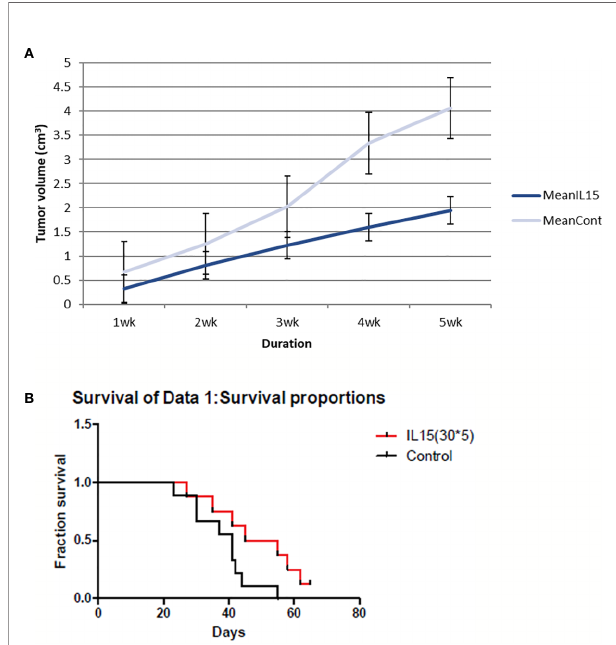
FIGURE 1 | 4T1 tumor volume and mice survival graph after IL-10 injection compared to control mice (n=12 each group). (A) Tumor volume was measured every week after 4T1 cell inoculation with or without IL-10 treatment. Grey line means control group and blue line means the IL-10 group. IL-10 therapy caused statistically signi fi cant tumor volume shrinkage (standard error is used in the graph). (B) Mice survival was measured each week after 4T1 cell inoculation with or without IL-10 treatment. Red line means IL-10 treated group and black line means control group. IL-10 treatment signi fi cantly prolonged mice survival. (Likelihood P value=0.020, median survival for control group=35.5 days and for IL-10 treated group=48.5 days).